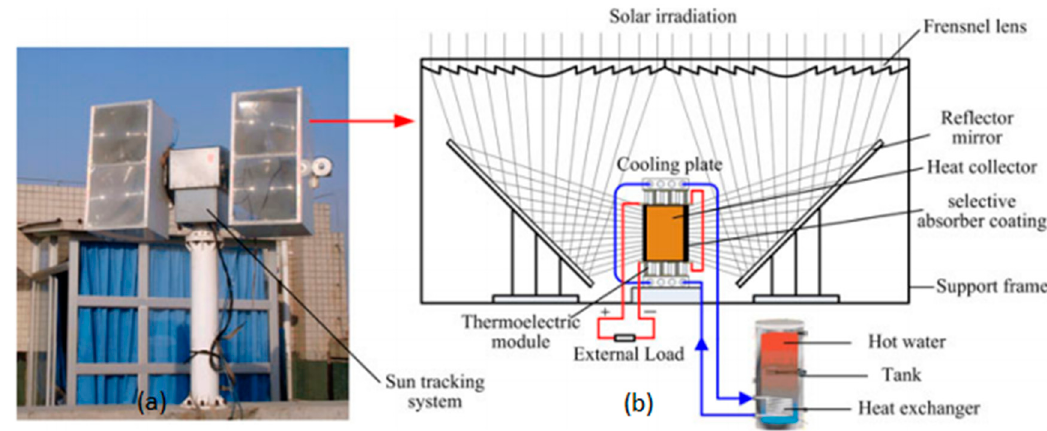
Figure 15. Illustration of a STEG cell consisting of a pair of thermoelectric elements type p and n [158]. Figure 16. Concentrating Solar Thermoelectric Generators (CTG): ( a ) An experimental prototype of the Concentrating Solar Thermoelectric Generator System; ( b ) Details of the CTG unit [149].